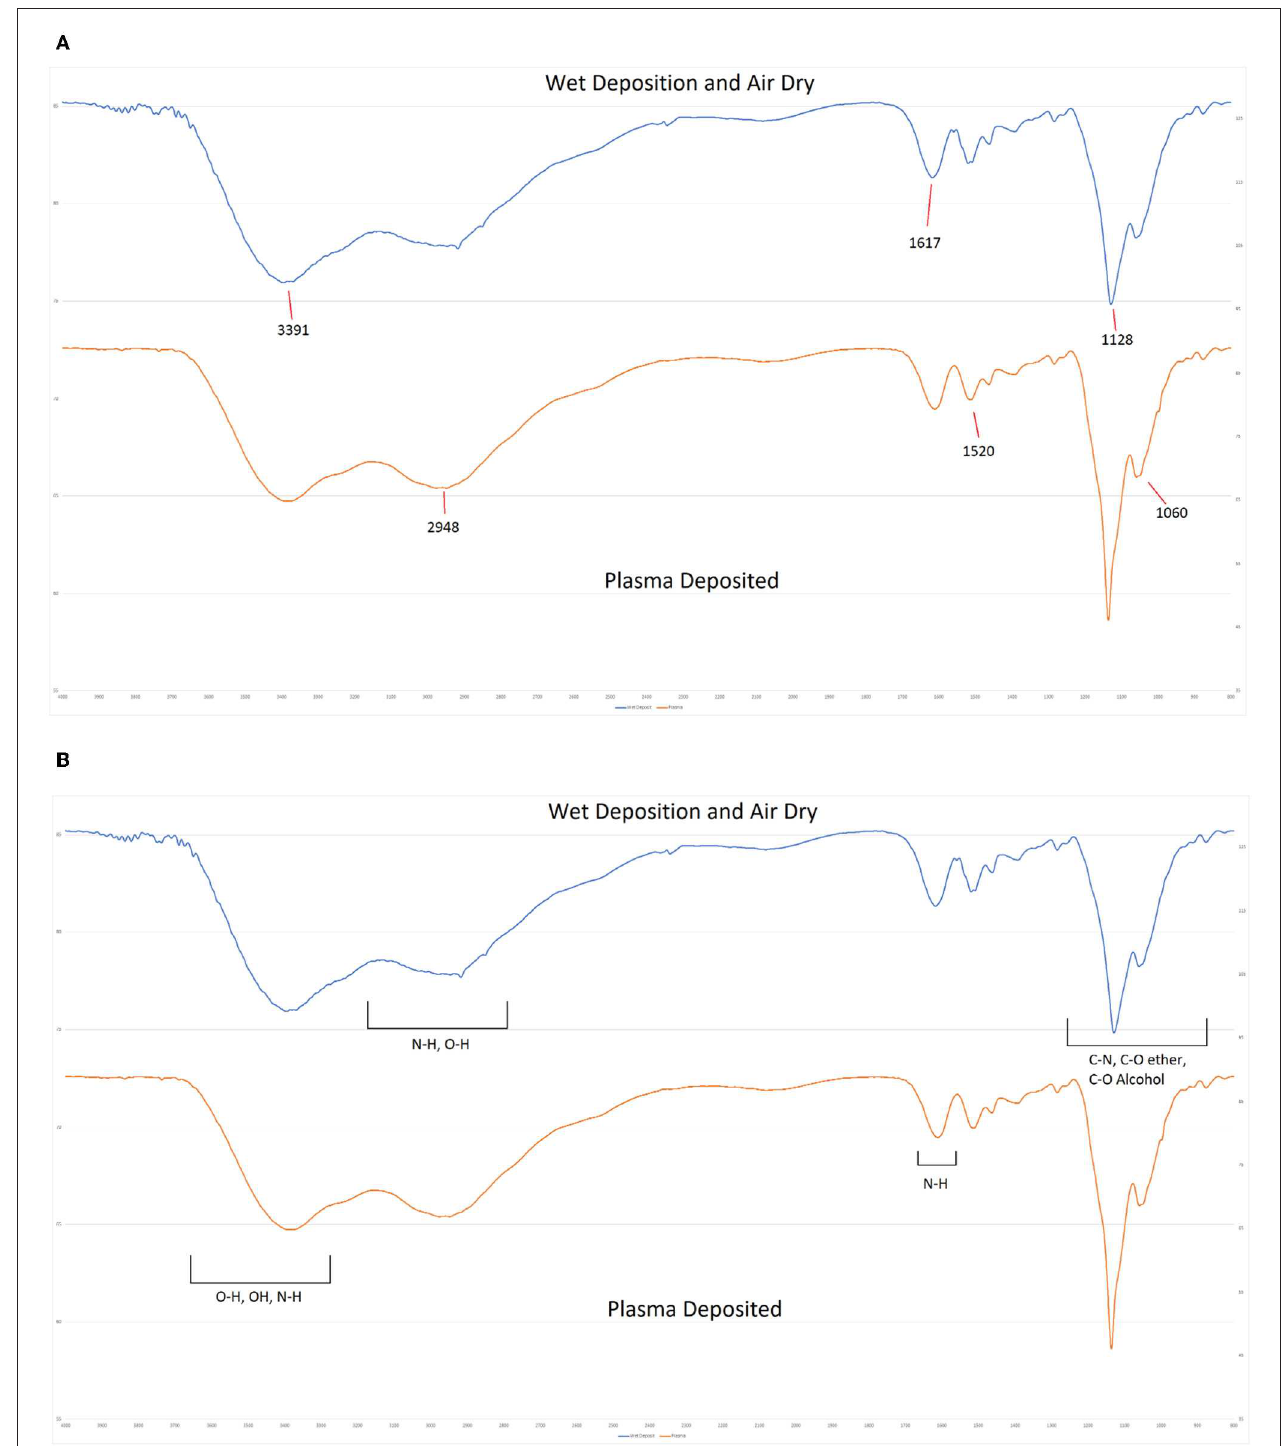
FIGURE 10 | FTIR Spectra of plasma deposited gentamicin coating (Top) and air dried gentamicin solution (Lower) .